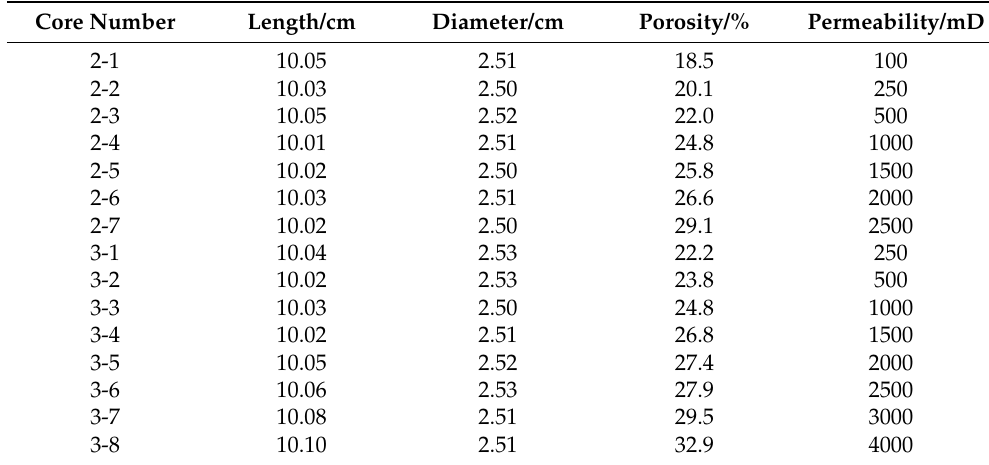
Table 4. The parameter for the artificial core.